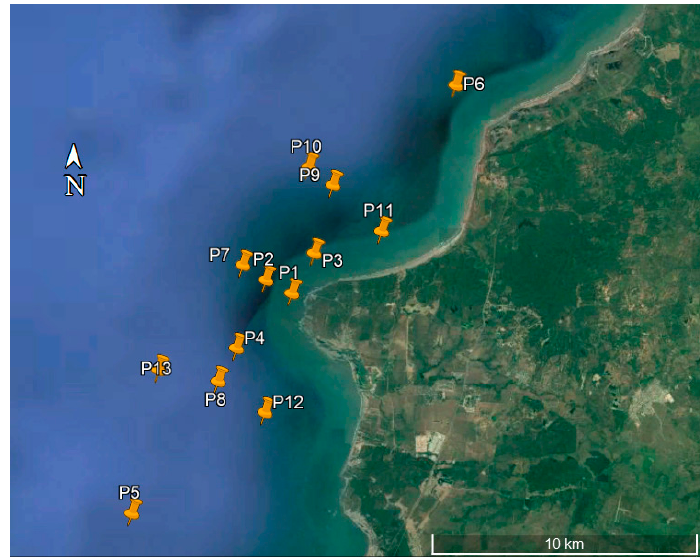
Figure 2. Sampling points in the study area. Source: Google Earth, 2018, Modified by authors.